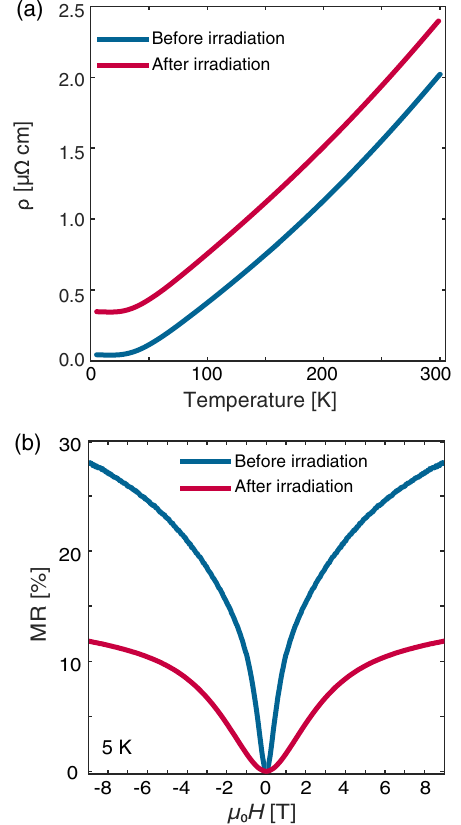
FIG. 13. The (a) temperature-dependent resistivity and (b) mag- netoresistance [MR ¼ ½ ρ ð H Þ − ρ ð 0 Þ(cid:2) = ρ ð 0 Þ ] of the sample shown in Fig. 12 before and after